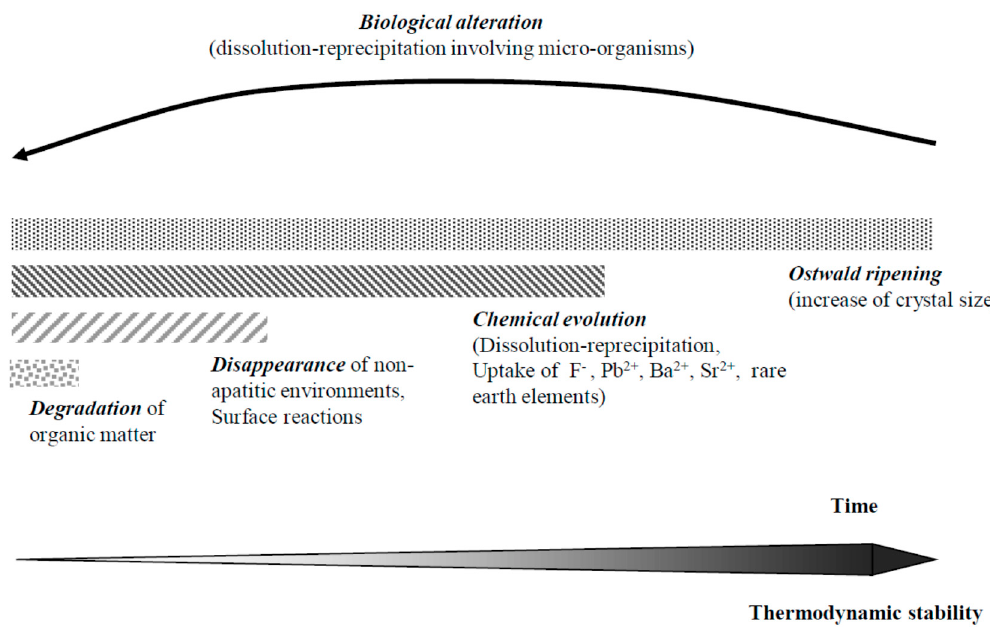
Figure 6. The various phenomena involved in the diagenetic evolution of biological apatites (adapted from [145]).